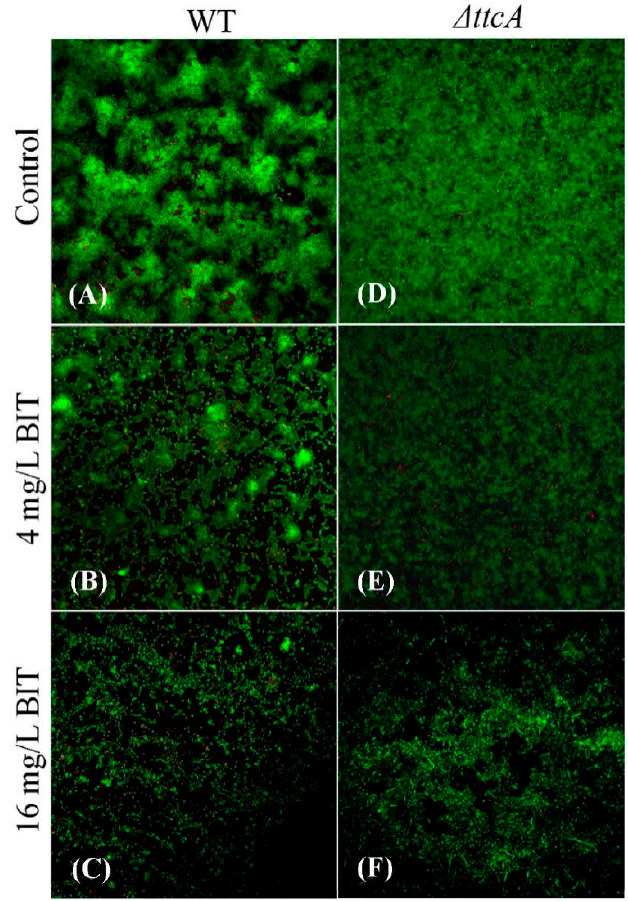
Figure 6. CLSM images of 4 days old biofilms of C. werkmanii BF-6 and Δ ttcA in the presence of 0